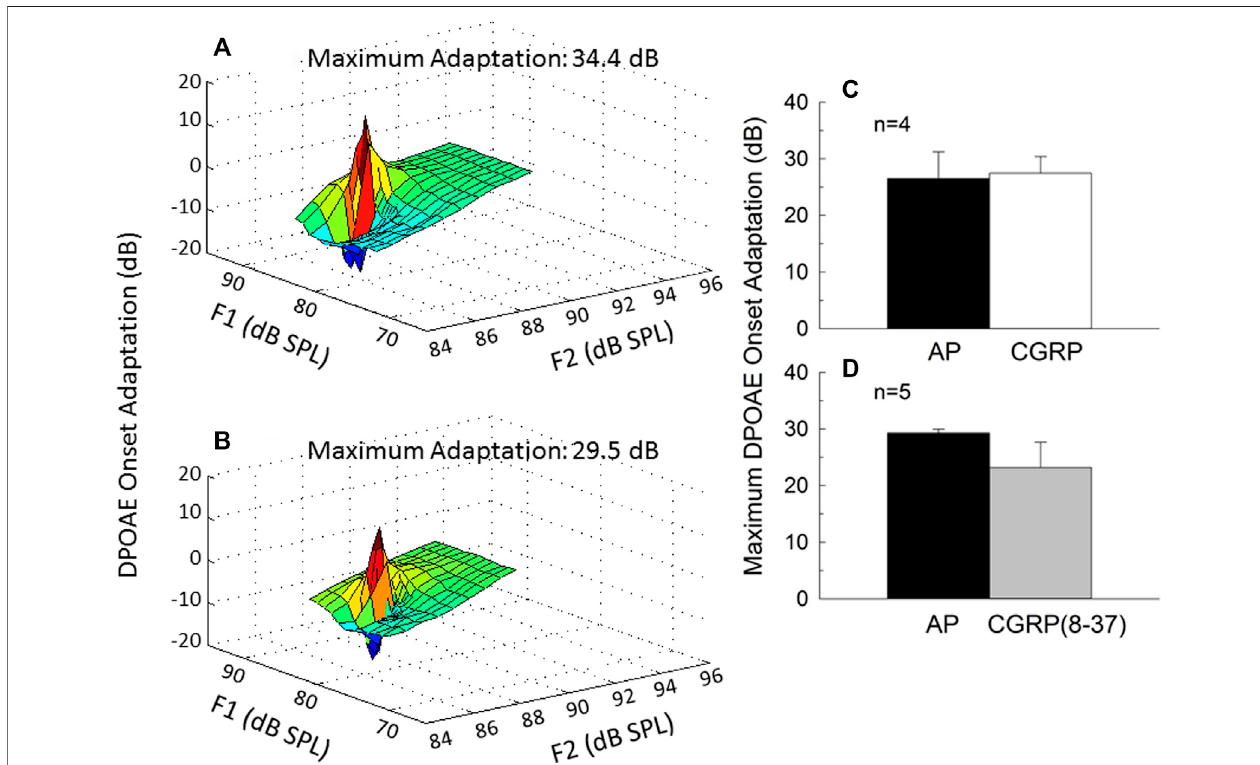
FIGURE 5 | Onset adaptation of the outer hair cell distortion product otoacoustic emission (DPOAE) shows a rapid level-dependent adaptation shortly after signal onset when the medial olivocochlear pathway is intact. DPOAE adaptation is depicted on day 9 of arti fi cial perilymph (A) and CGRP (B) infusion for one representative animal. The maximum adaptation was extracted from the fi ne-structure plots shown in (A,B) . Onset adaptation was not reliably affected by either CGRP (C) or CGRP (8 – 37) (D) (all p ’ s > 0.25).